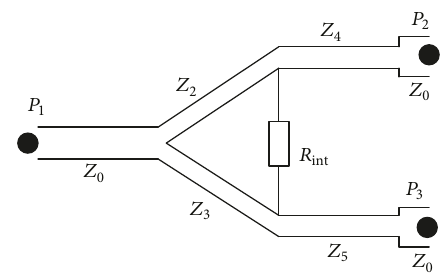
Figure 2: Topology of N :1 practical Wilkinson unequal power